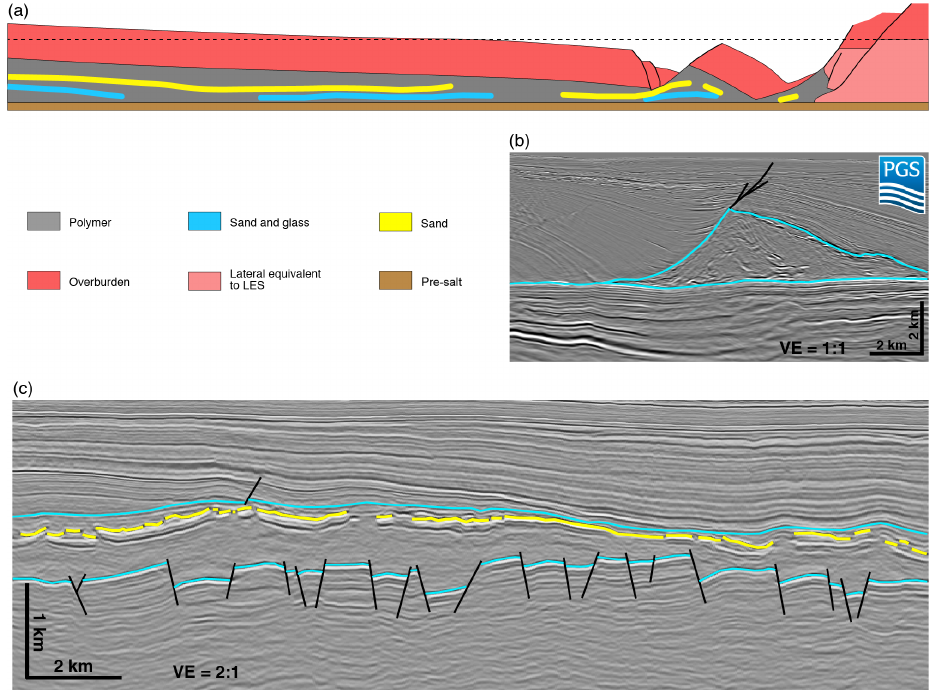
Figure 5. Examples of extension of salt with internal competent beds: (a) simplified results of analog model in which the polymer layer was thinned and attenuated during thin-skinned extension – the black dashed line shows the original top polymer, and the yellow and blue layers are stronger intra-polymer layers that separated into boudins, with more extension at the deeper, blue level (adapted from Cartwright et al., 2012; model by Tim P. Dooley); (b) 3-D depth-migrated image of a large salt roller from the Santos Basin (vertical exaggeration 1 : 1), with very little of the internal layering seen in Fig. 2e visible here due to more disruption during extension (data courtesy of PGS Investigação Petrolifera Limitada); (c) 3-D depth-migrated seismic profile (vertical exaggeration 2 : 1) from the Friesland Platform of the onshore Netherlands showing the Zechstein salt (between cyan horizons) with boudins of the Z3 stringer (top of stringer in yellow) generated during thick-skinned extension (adapted from Strozyk et al.,